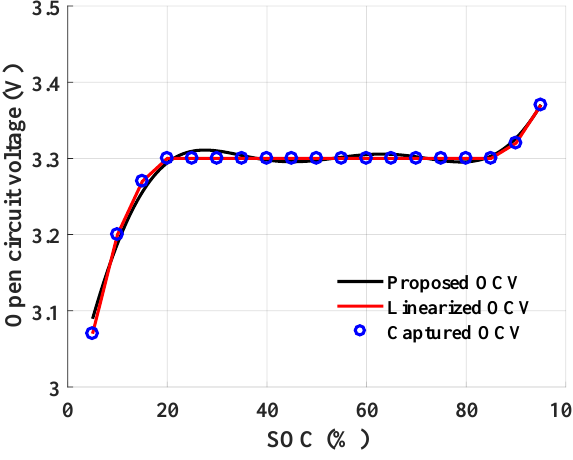
Figure 16. SOC-OCV relationship with wide flat area and two kinds of representation of OCV curve. The SOC estimation results of proposed nonlinear-model in (10) and linearized model in (5) are shown in Figure